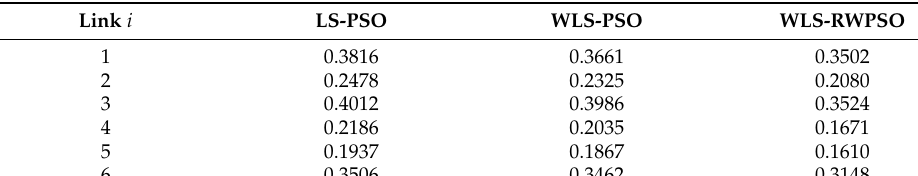
Table 3. The root mean square error of different algorithm identifications.